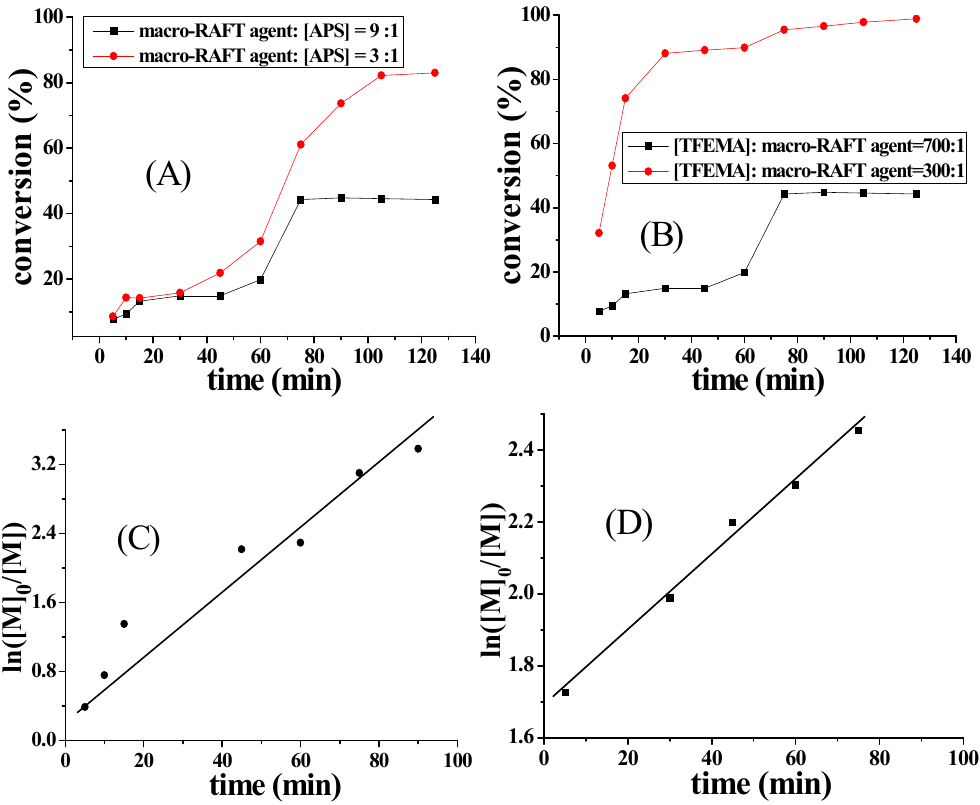
Figure 7. Evolutions of TFEMA conversion versus time for RAFT-mediated aqueous polymerization.